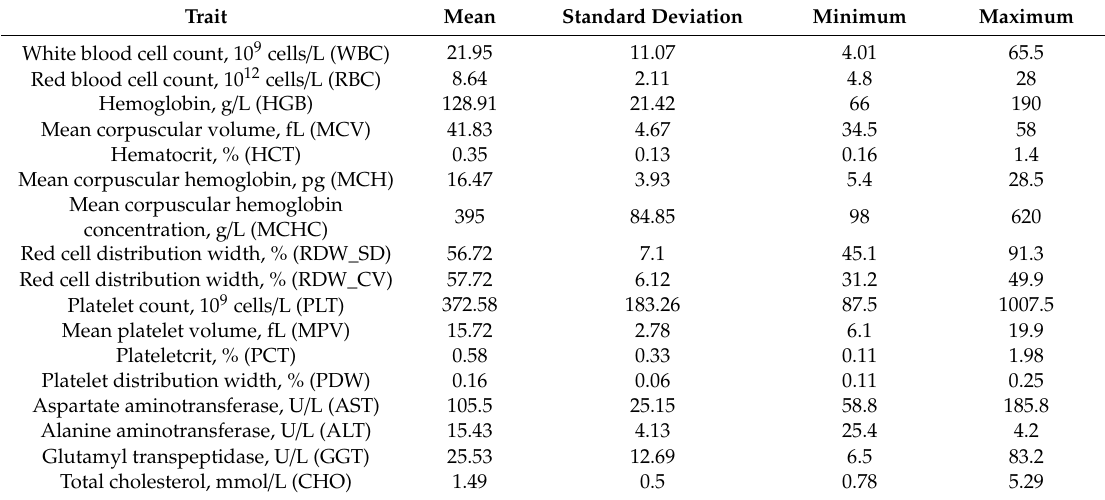
Table 1. Summary statistics of phenotypic traits used in genotyping-by-sequencing and the genome-wide association study